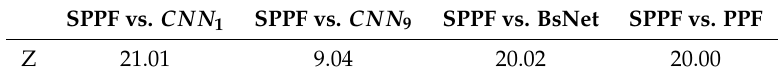
Table 5. Statistical difference of SPPF over competitive models with the standardized McNemar test. BsNet, band-sensitive network.